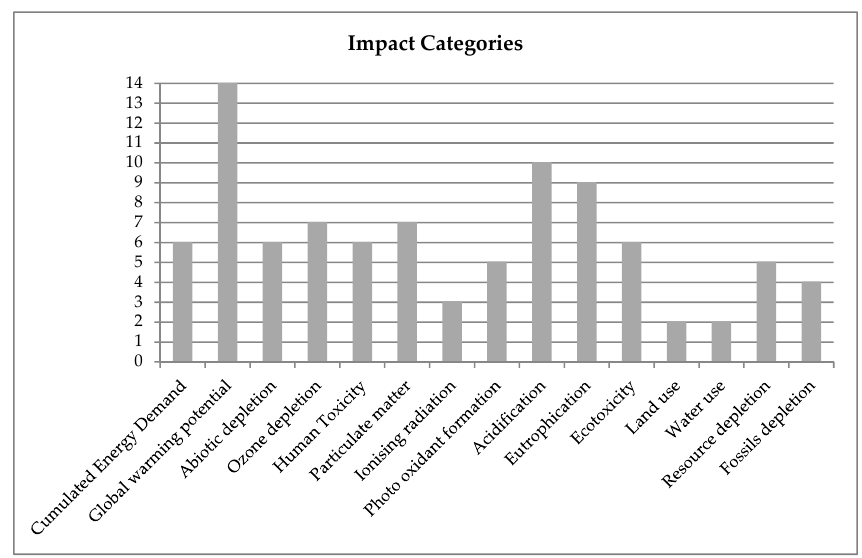
Figure 1. Impact categories used in the assessed studies.